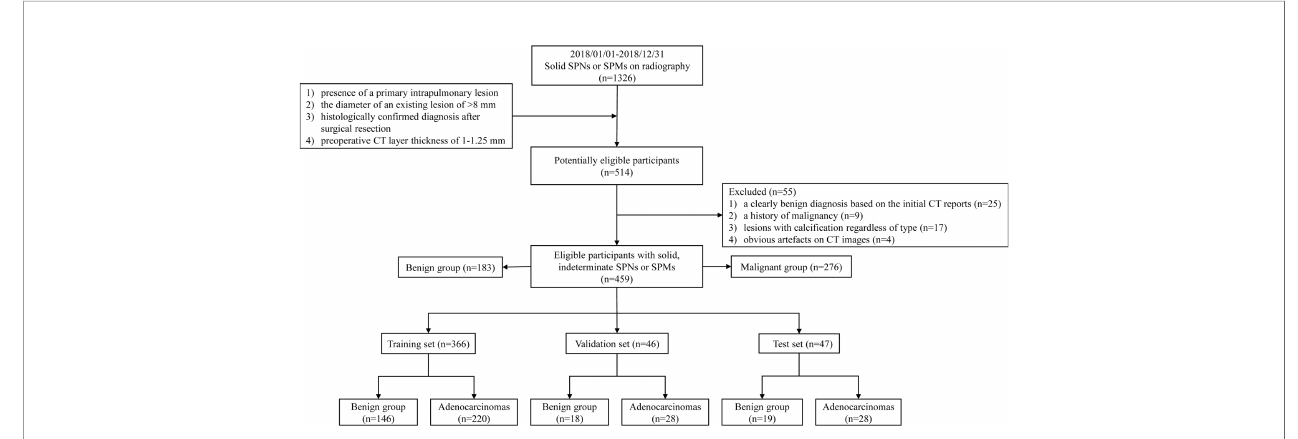
FIGURE 2 | Flow chart of inclusion and exclusion criteria for eligible patients and speci fi c allocations in the train, validation, and test sets.